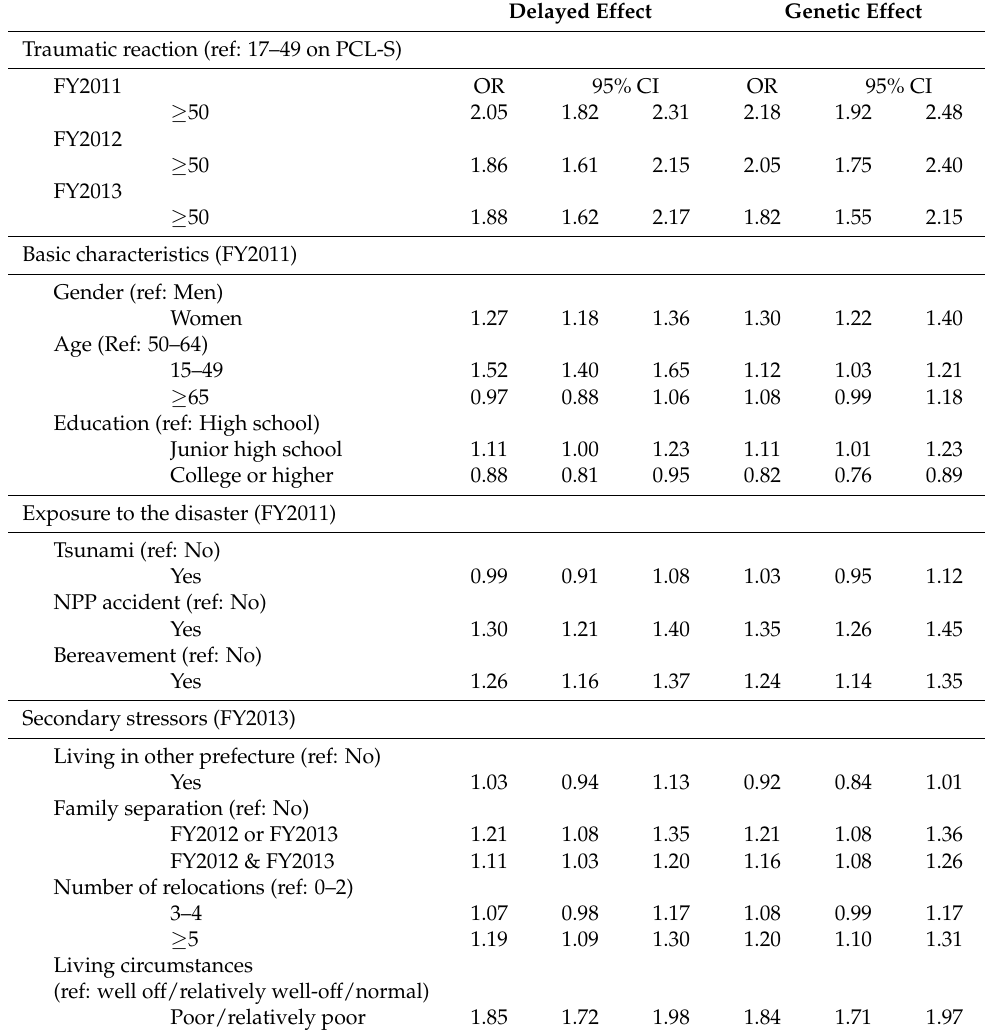
Table 1. Predictors of being in the high-risk perception group for the delayed and genetic effects based on logistic regression